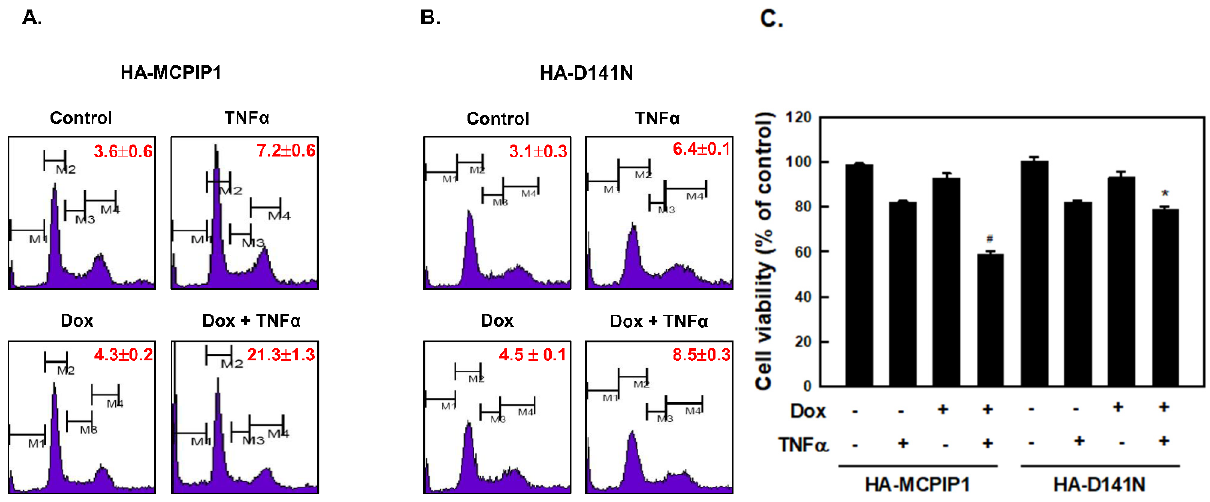
Figure 1. Overexpression of MCPIP1 enhanced the TNF- α -induced sub-G1 population. T-REx-293 cells with ( A , C ) wild- type hemagglutinin (HA)-MCPIP1 or ( B , C ) the HA-MCPIP1-D141N mutant (HA-D141N) were pretreated without or with 1 μ g/mL of doxycycline (Dox) for 16 h, and then treated with 10 ng/mL TNF- α for 2 h. ( A , B ) The cell cycle distribution was determined by FACS using propidium iodide staining, and each percentage (%) of sub-G1 population is shown, and ( C ) the cell viability was analyzed using an MTT method. M1, sub-G1 population; M2, G0/G1 population; M3, S population; M4, G2/M population. Each value is presented as the mean ± standard error of three independent experiments. # p < 0.05 vs. column 2 or column 3; * p < 0.05 vs. column 7.